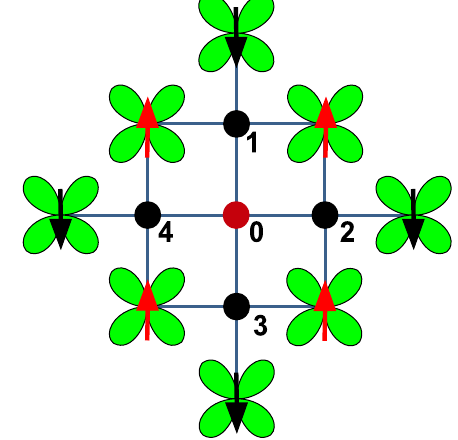
FIG. 5. Schematic top view of the cluster used to obtain the phase diagrams of the 3 d impurity within the 4 d host in an ð a; b Þ plane. The impurity is at the central site i ¼ 0 that belongs to the c -orbital host sublattice. For the outer sites in this cluster, the spin-orbital configuration is fixed and determined by the undoped 4 d host (with spins and c orbitals shown here) having C -AF or G -AO order; see Fig. 2. For the central i ¼ 0 site, the spin state, and for the host sites i ¼ 1 ; … ; 4 , the spin-orbital configurations are determined by minimizing the energy of the